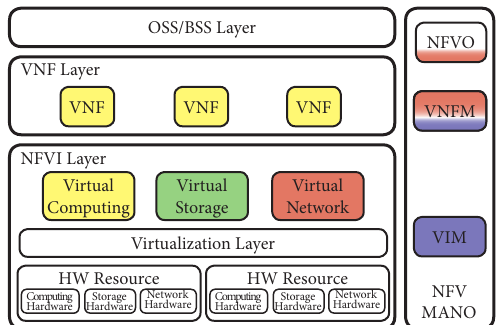
Figure 1. The ETSI NFV Architecture and its relationship with Megalos. In yellow the parts imple- mented using Docker, in green the Kubernetes volume drivers, in blue Kubernetes itself, and in red the Megalos Controller and